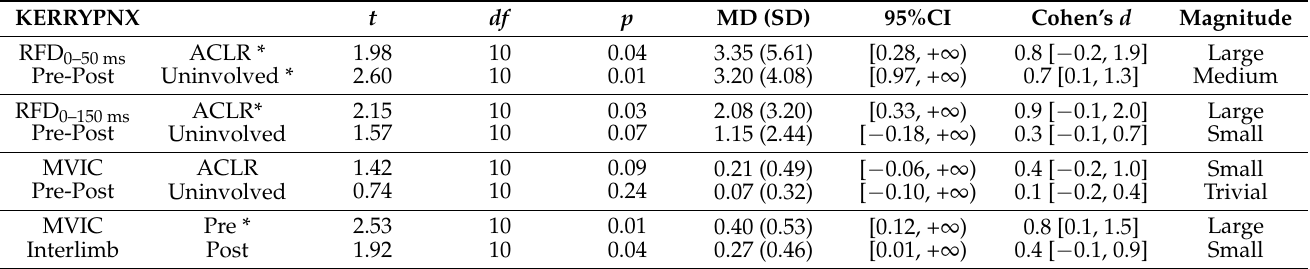
Table 2. Summary of the one-tail, paired t-test statistics and effect size. RFD: Rate of force de- velopment (Nm/kg/s); MVIC: Maximum voluntary isometric contraction (Nm/kg); ACLR: ACL- reconstructed limb; t : t-value; df : Degrees of freedom; p : p -value; MD: Mean difference; SD: Standard deviation; 95%CI: 95% Confidence interval.